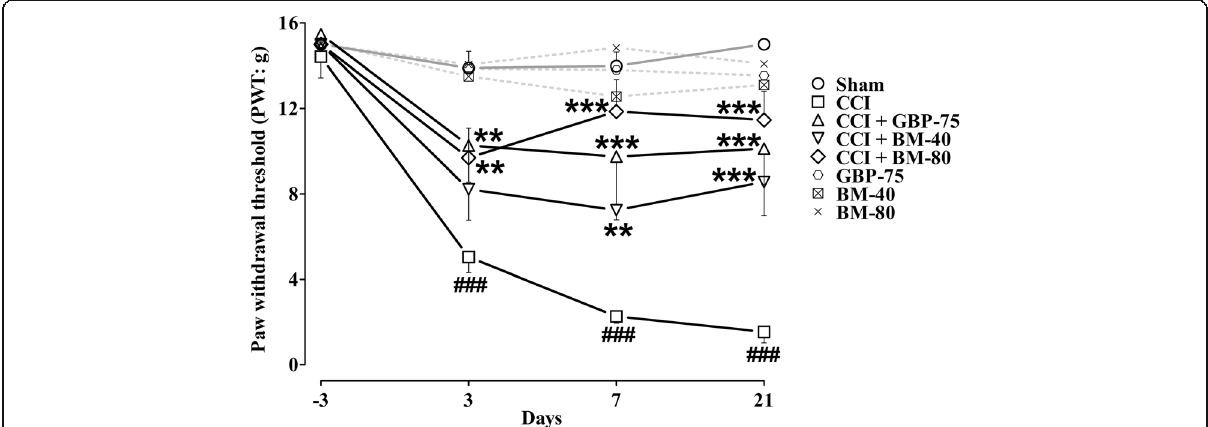
Fig. 2 Effect of Bacopa monnieri methanolic extract (BM-40 and BM-80) and gabapentin (GBP-75) on the maintenance of chronic constriction injury (CCI) induced static allodynia (diminished von Frey filament threshold pressure; PWT in g). Values expressed as mean ± S.E.M. ### P < 0.001 compared to sham-operated animals, ** P < 0.01, *** P < 0.001 compared to CCI-operated untreated animals, two-way repeated measures ANOVA followed by post hoc Bonferroni analysis. n = 6 rats per